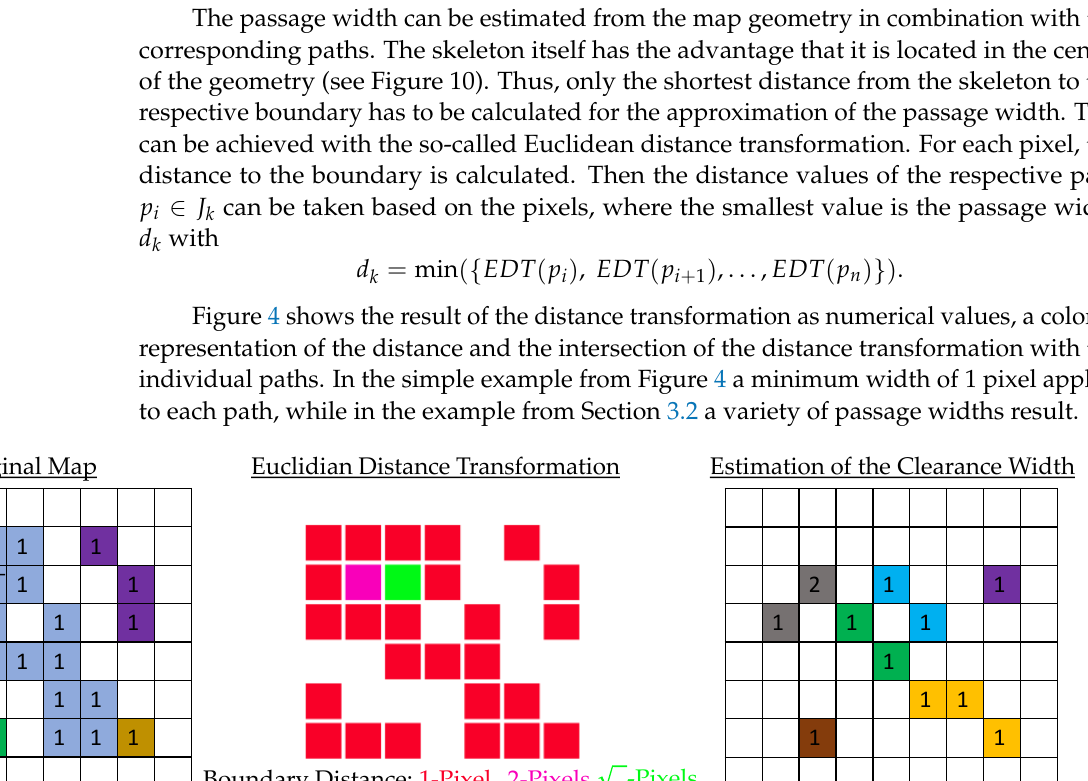
Figure 3. Polyline path estimation: topological segmentation of the skeleton, path segmentation, collapse metric for path simplification, simplified path as a polyline.